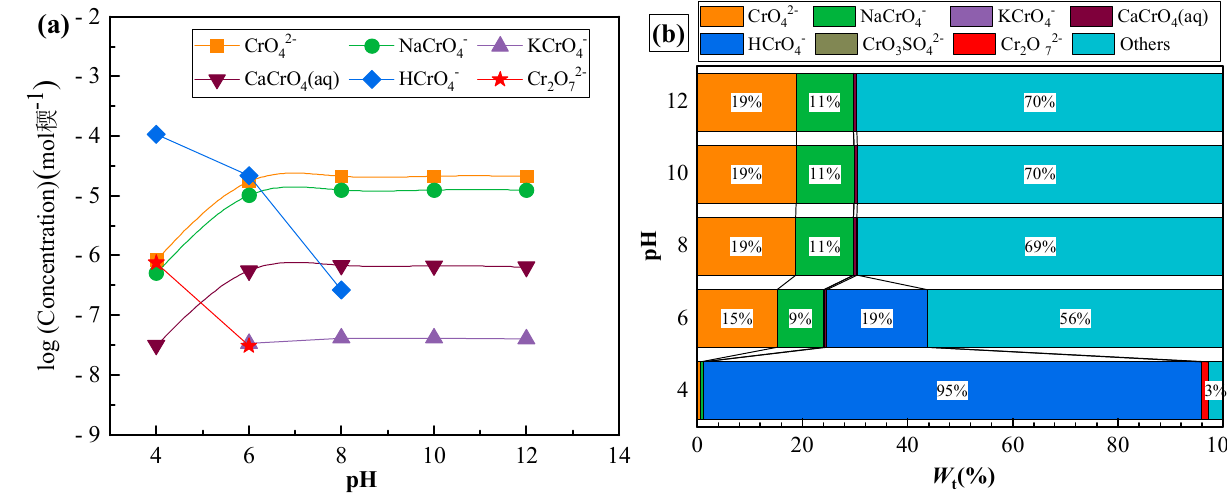
Figure 3 . ( a ) Variations in chromium concentration with pH after adsorption; ( b ) fractional concentrations of various forms of total chromium at different pHs after adsorption